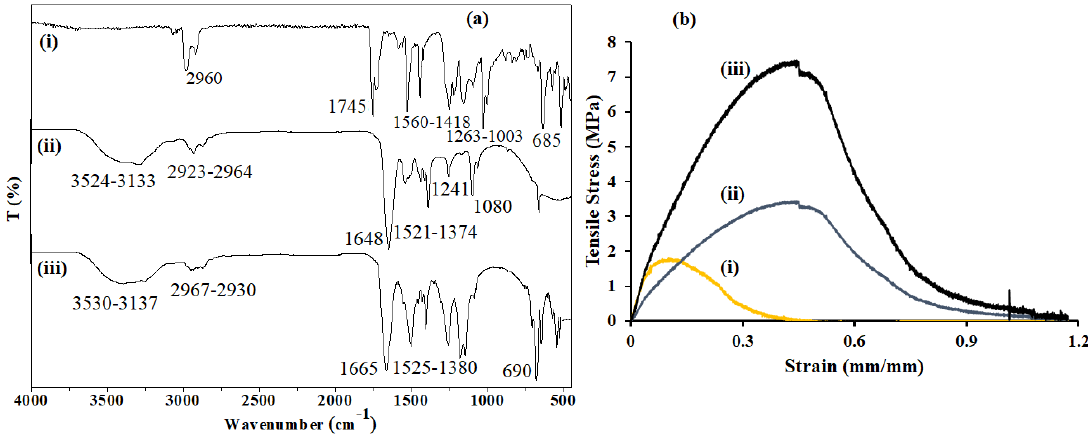
Figure 4. ( a ) FTIR spectra of (i) pure f-CNOs, (ii) pristine zein, and (iii) UZCNOs. ( b ) Tensile graph of (i) CZCNOs, (ii) MZCNOs, and (iii) UZCNOs hydrogels, respectively.